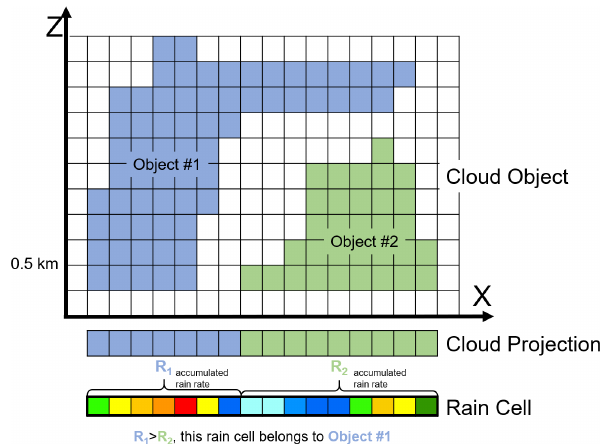
Figure 3. The schematic diagram of connecting cloud objects and rain cells, as well as co-locating the cloud objects with the rain cells along the x – z cross-section. Anvil of cloud object no. 1 (blue cloud) is overlapped with cloud object no. 2 (green cloud). The cloud pro- jection to the surface is based on the lowest cloud bottom. For a con- nected rain cell covered by multiple cloud objects, the co-location is simplified by identifying the cloud object that contributes to the highest fractional rainfall. For example, the accumulated rain rate to the rain cell from cloud object no. 1 is more than that from cloud object no. 2, so the rain cell in this diagram would be co-located entirely with cloud object no.